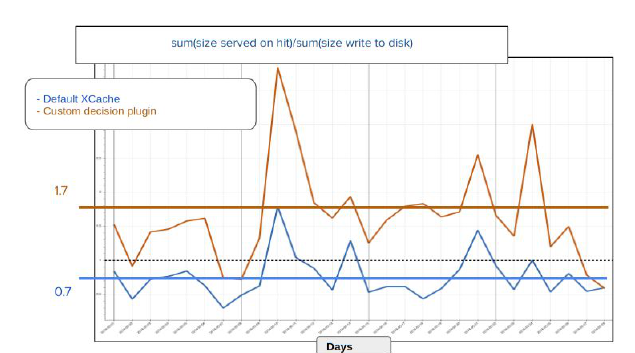
Fig. 5 . The plot shows the sum(size served on hit)/sum(size write to disk) for jobs running only on US Tier2s. Brown color refers to the